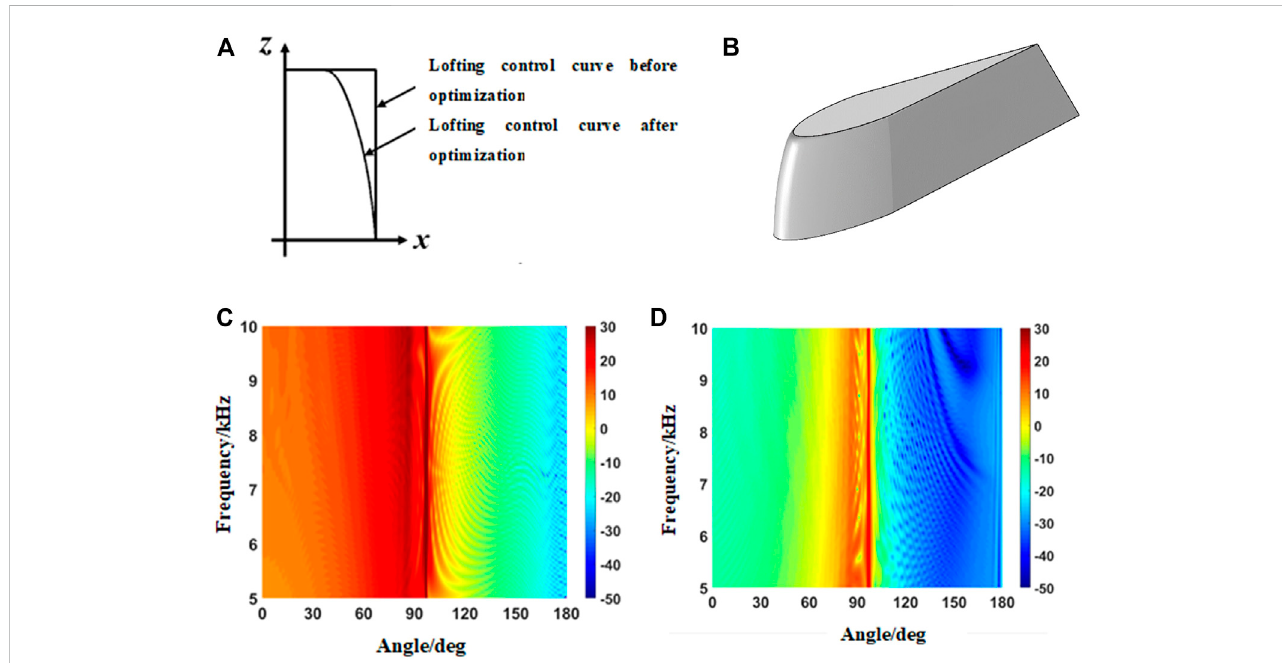
FIGURE 9 Optimized conning tower models. (A) Lofting control curve comparison. (B) Optimized conning tower model. (C) Angle – frequency spectra of the conning tower TS before optimization. (D) Angle – frequency spectra of the conning tower TS after optimization.